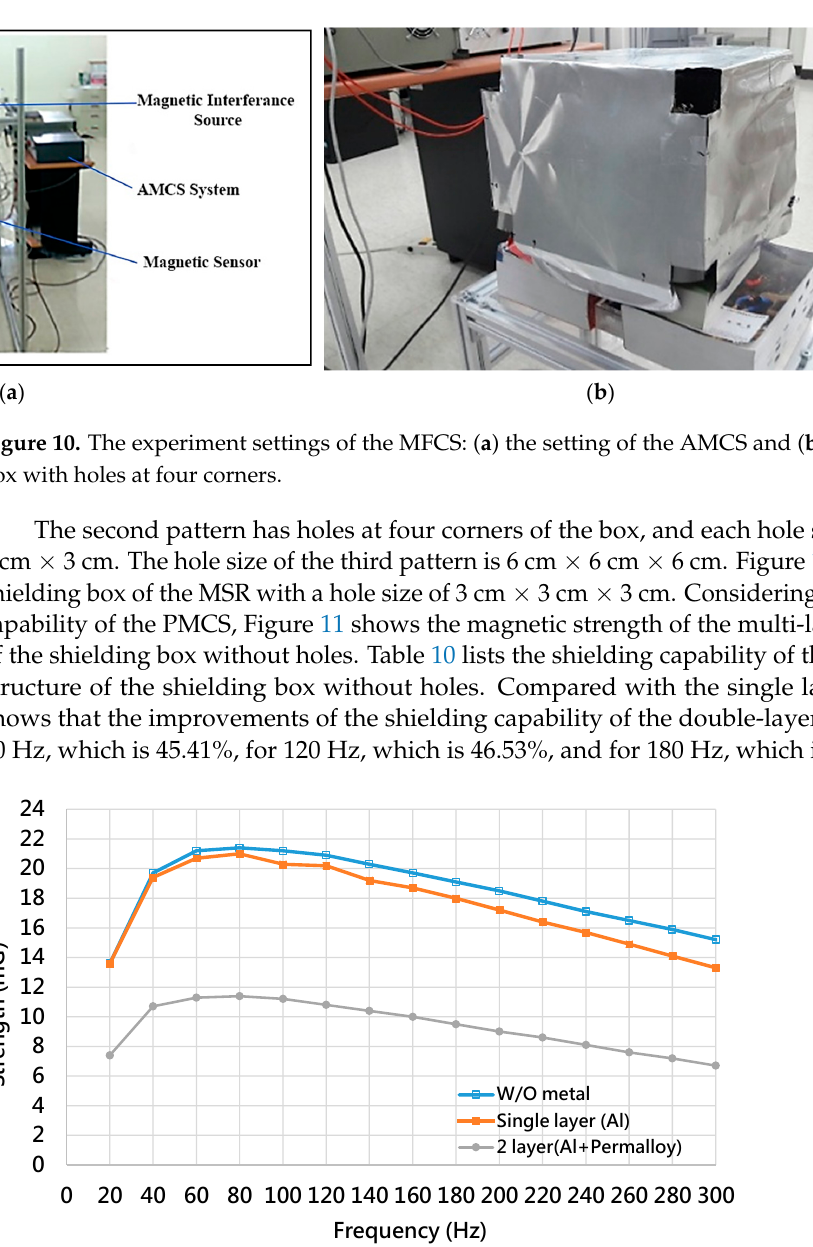
Table 9. Comparison between cost saving in different hole pattern. Cost Saving